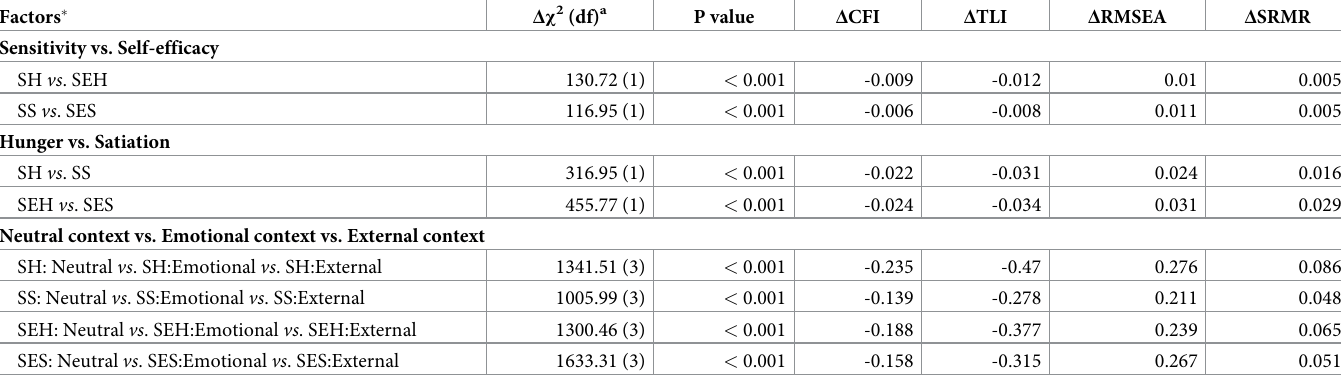
factor SEH. In the alternative model, the two second-order factors were collapsed into one fac- tor. The alternative model had significantly lower fit. The same was the case for the distinction between SS and SES. Table 3. Change in chi square and fit indices between models testing the discriminant validity of MIRES constructs. Factors � Δχ 2 (df) a Sensitivity vs. Self-efficacy